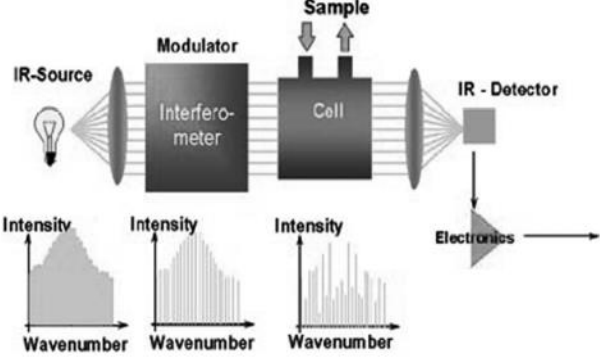
Figure 2. Schematic diagram of measuring principle of an FTIR